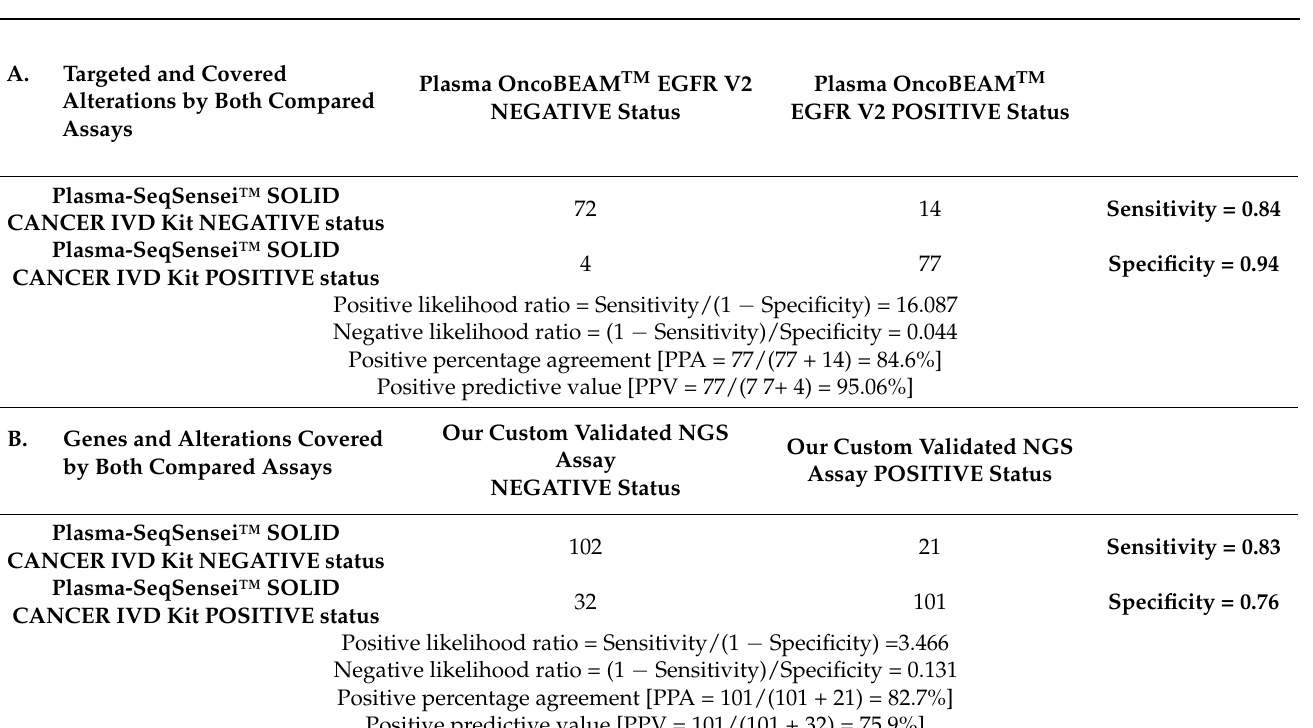
Table 3. Performance of the assays. A. Focus on EGFR targeted clinical alterations covered by the Plasma OncoBEAM TM EGFR V2, given by Plasma OncoBEAM TM EGFR V2 and Plasma-SeqSensei™ SOLID CANCER IVD assays; B. focus on KRAS , EGFR , and PIK3CA genes covered by the Plasma- SeqSensei™ SOLID CANCER IVD kit vs. our custom validated NGS assays. Sensitivity and specificity calculation based on https://probabilitycalculator.guru/sensitivity-and-specificity-calculator/ (ac- cessed on 29 December 2022). PPA and PPV calculation according to Jennings, 2017